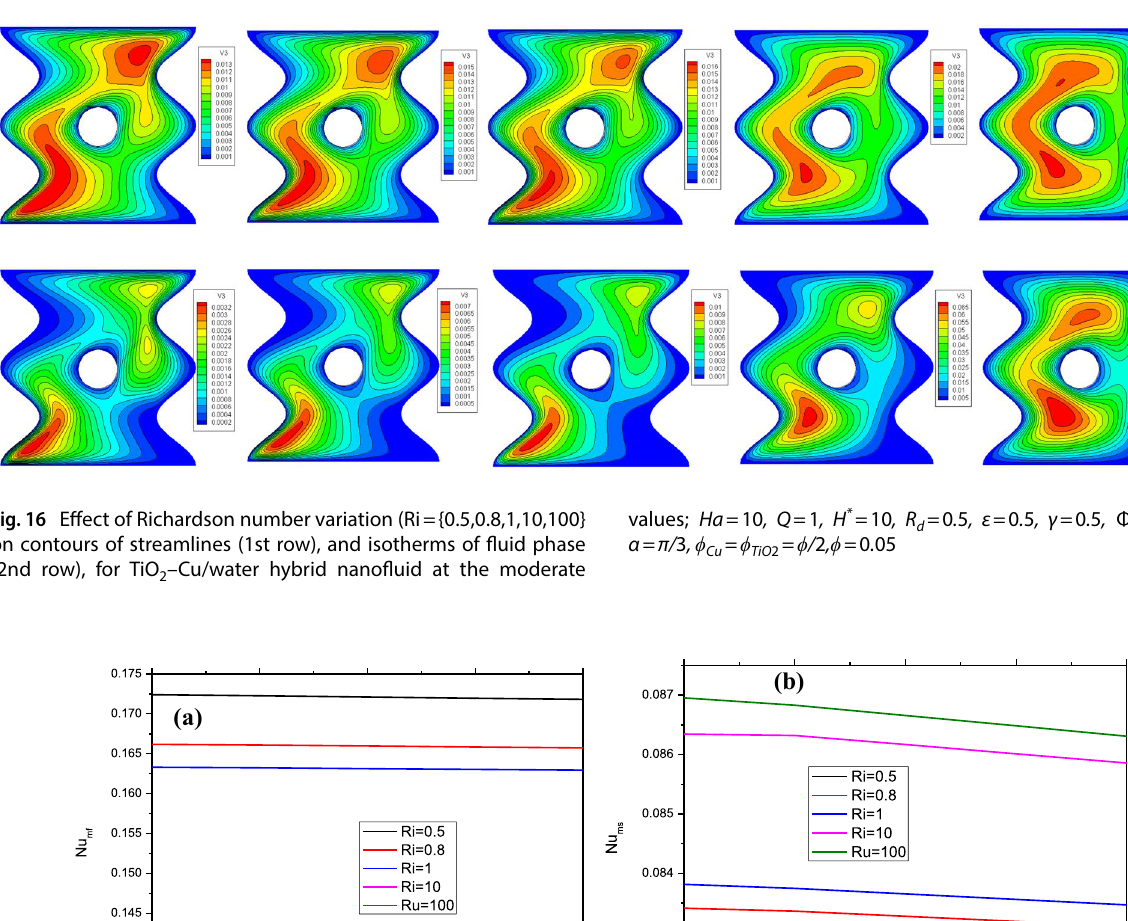
–Cu/water Hybrid 2 = ϕ = ϕ / 2 , ϕ = 0 . 05 Cu TiO 2